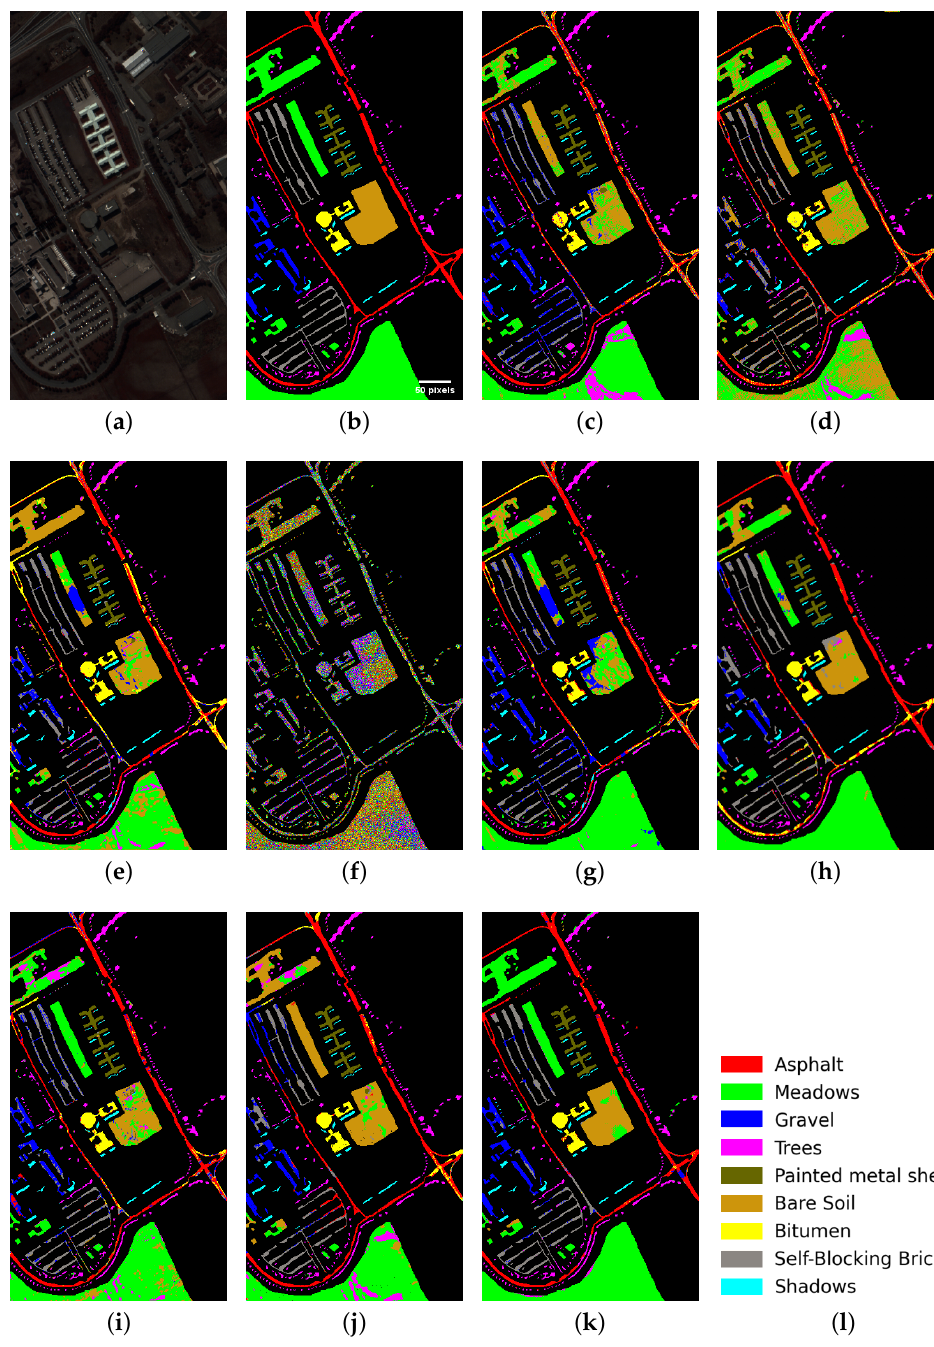
Figure 8. The classification maps for the PU with compared methods. ( a ) Source Image. ( b ) Ground Truth. ( c ) SVM. ( d ) 2D-CNN. ( e ) 3D-CNN. ( f ) HSI-BERT. ( g ) CA-GAN. ( h ) DCFSL. ( i ) VSCNN. ( j ) S-DMM. ( k ) Our proposed method. ( l )